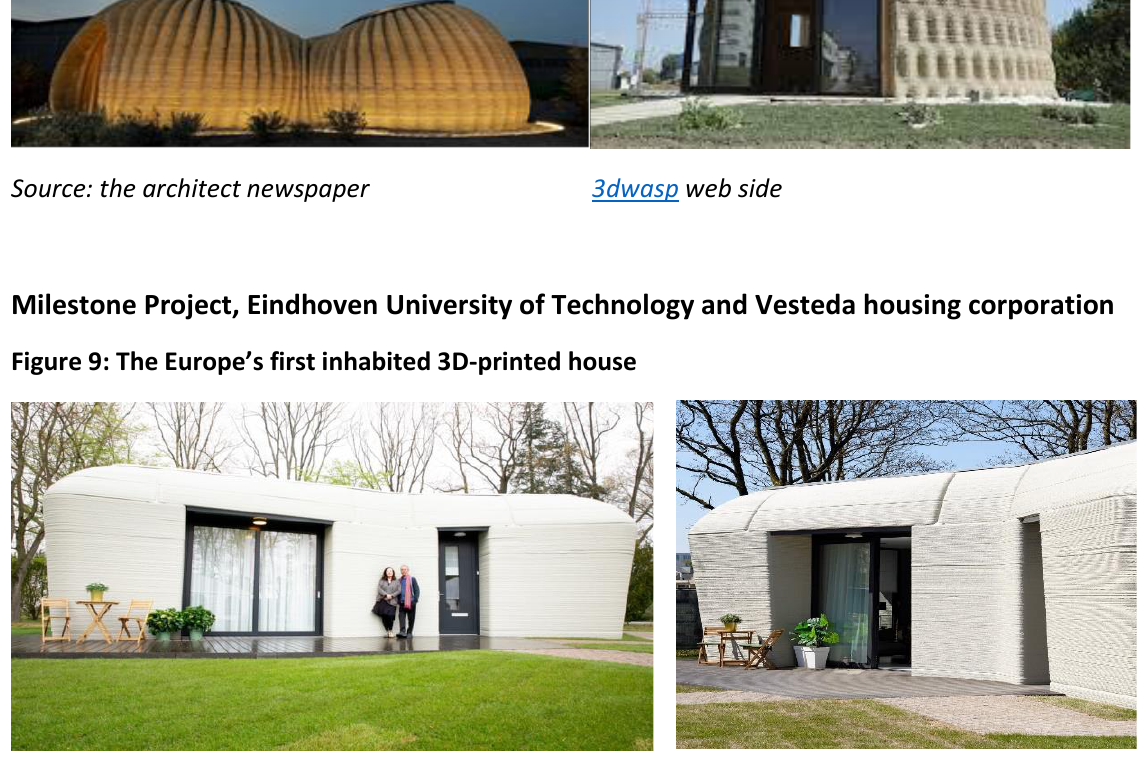
Source: theguardian.com